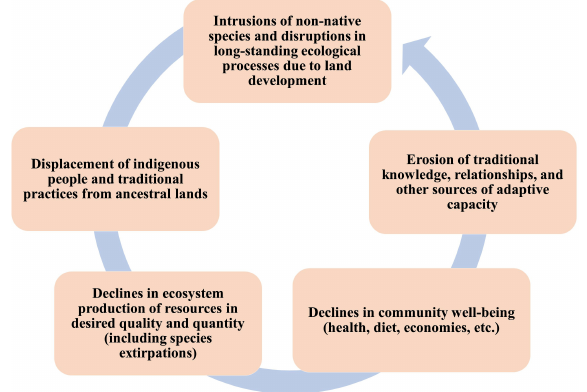
Fig. 2. Factors contributing to a social-ecological trap by disrupting tribal relationships with ancestral ecosystems. We present the factors in a counter-clockwise direction to suggest that these processes are running counter to an expected or desirable